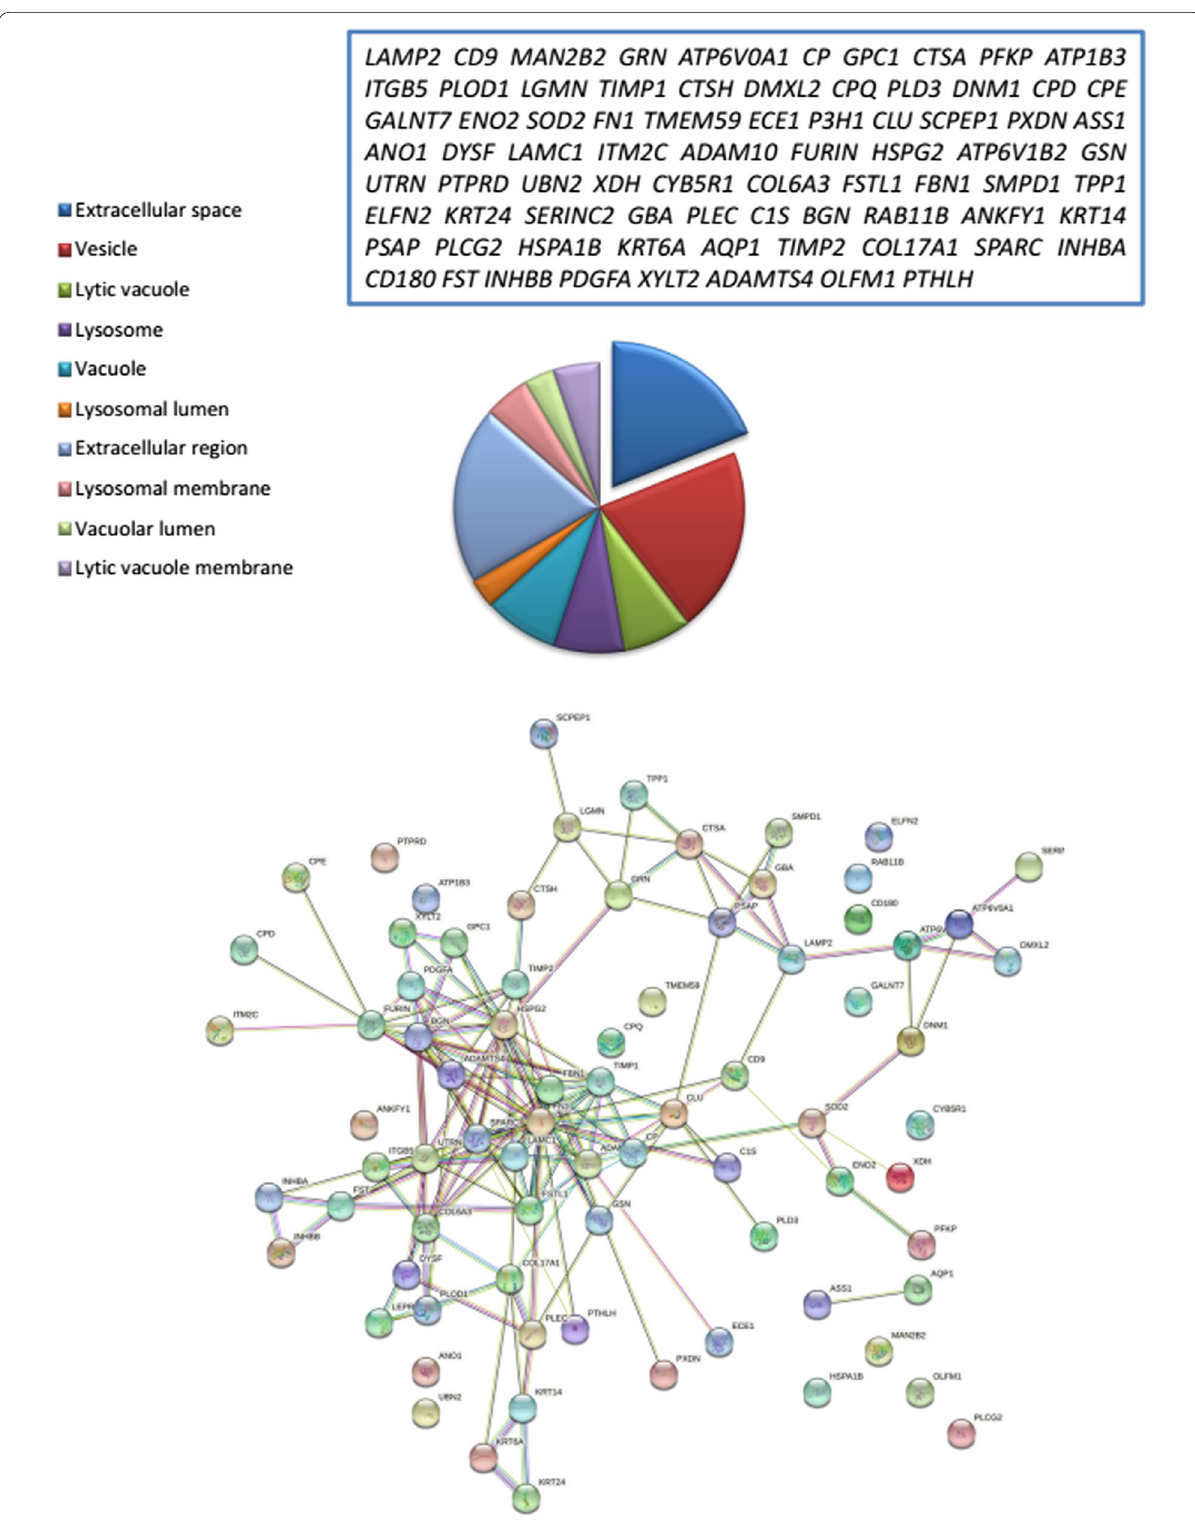
Fig. 4 In this image, the genes involved in the extracellular matrix are isolated, and then, a protein network is drawn between